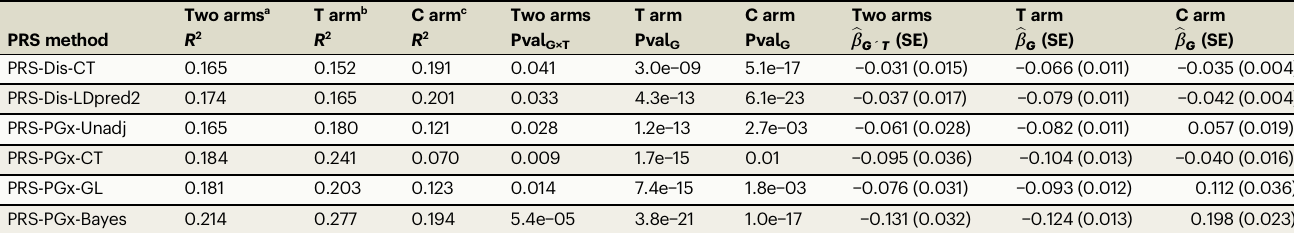
Table 1 | IMPROVE-IT PGx GWAS data analysis results: R 2 , p -values of two-sided test, and effect